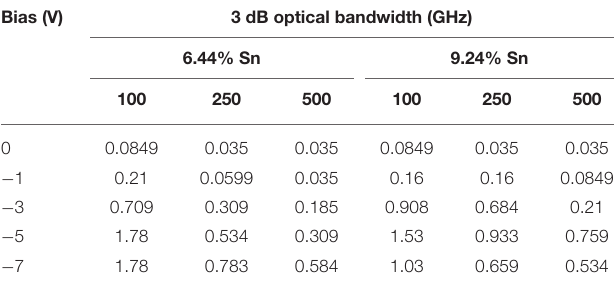
TABLE 1 | Bandwidth of the GeSn devices with different mesa sizes and at different bias voltages. Bias (V)